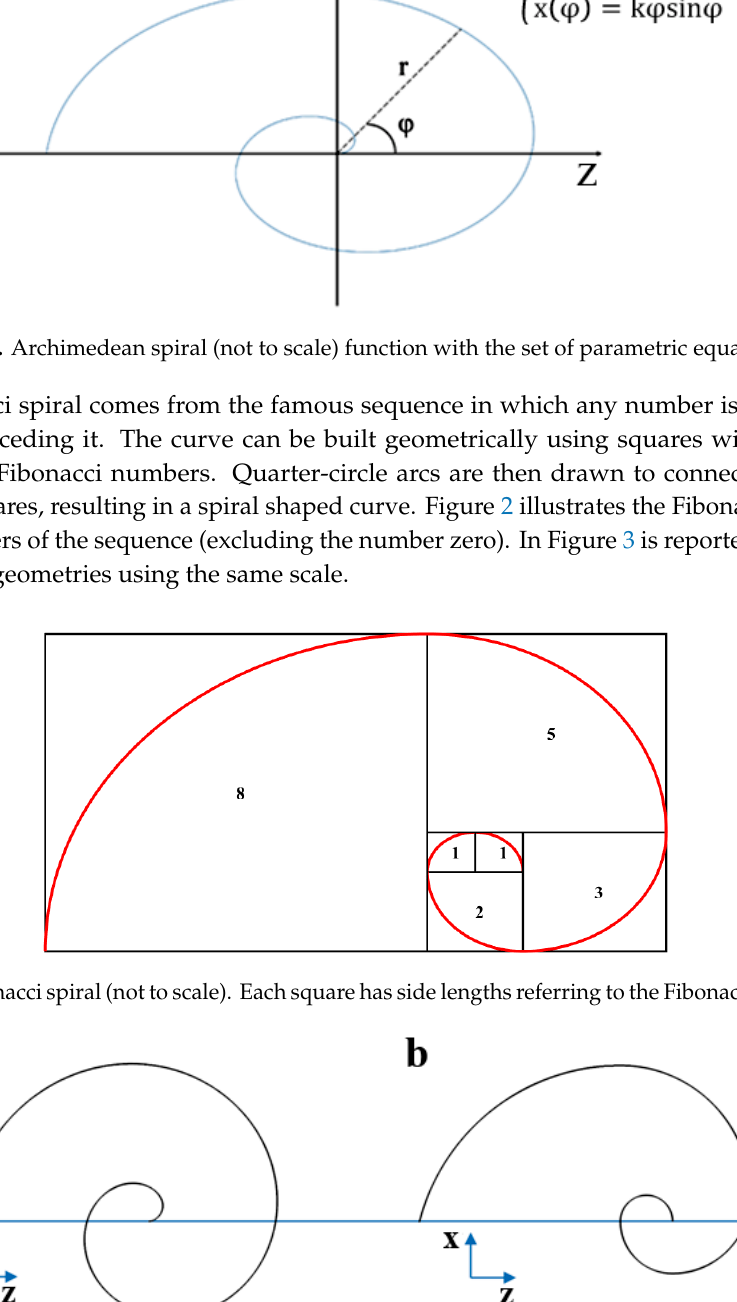
Figure 3. Comparison between the two-dimensional ( a ) Archimedean and ( b ) Fibonacci spirals according to the same